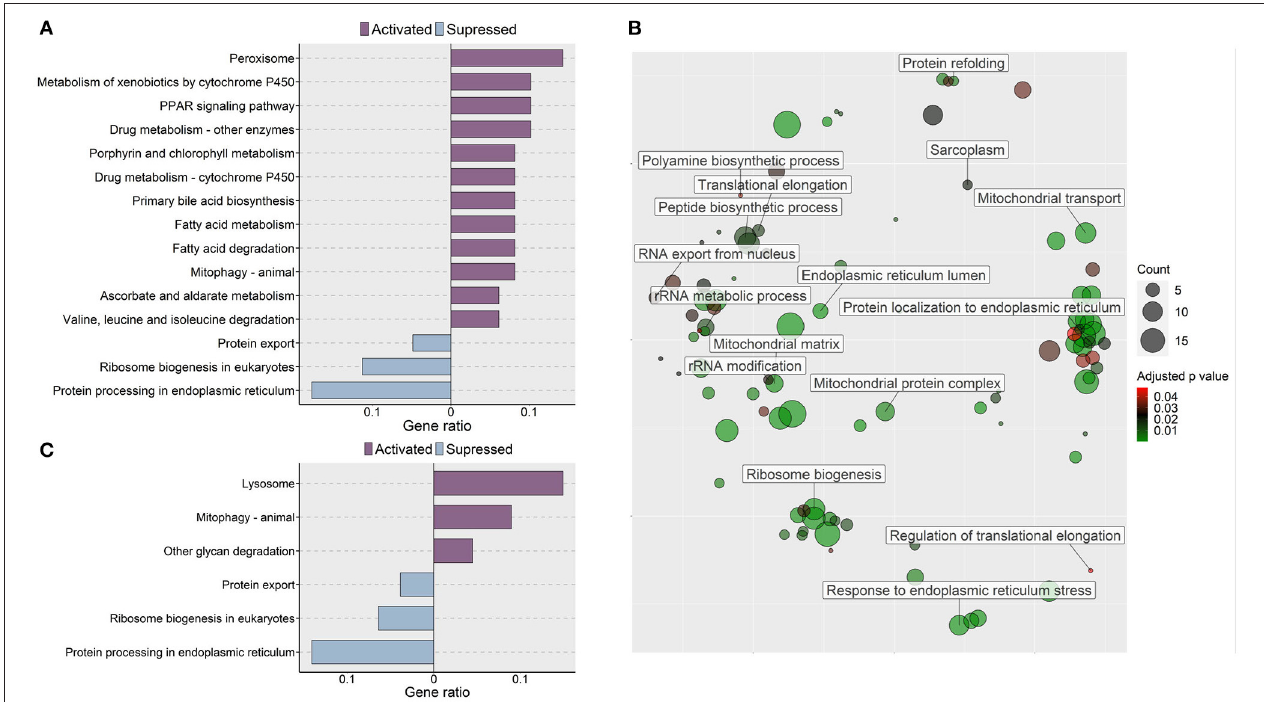
FIGURE 7 | Molecular effects of the oat glucan and simvastatin supplemented diets. (A) KEGG pathways that were altered in zebrafish fed the oat glucan (OG) diet. The enrichment analyses were performed by considering the differentially expressed genes in the OG fed zebrafish compared to the fish fed the high cholesterol (HC) diet. (B) Enriched GO terms in simvastatin fed (SS) group. Only the non-redundant GO terms are marked in the bubble plot, and the analysis was performed using the genes that were downregulated in the SS group compared to the HC group. The color of the circles ranging from green to red indicates the order of adjusted p value. Circle sizes are proportional to the gene number. (C) KEGG pathways that were altered in zebrafish fed simvastatin. The enrichment analyses were performed by considering the differentially expressed genes in the SS group compared to the HC group. Each treatment group consisted of at least five biological replicates.